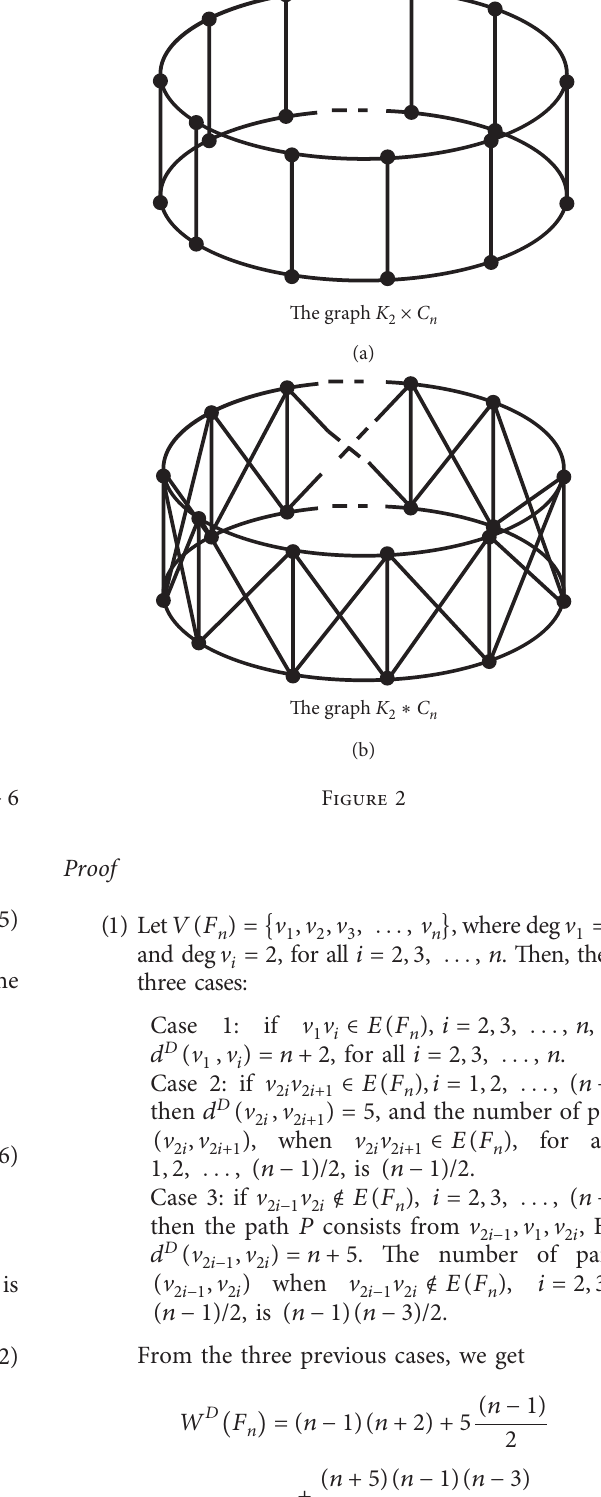
Figure 1 The graph K 2 × C